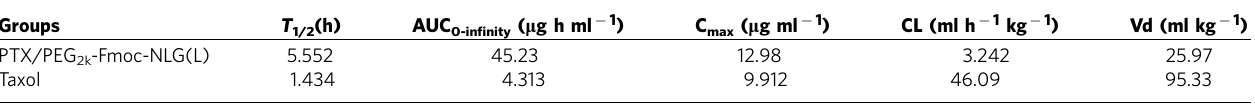
Table 3 | Pharmacokinetic parameters of PTX in different formulations. Groups